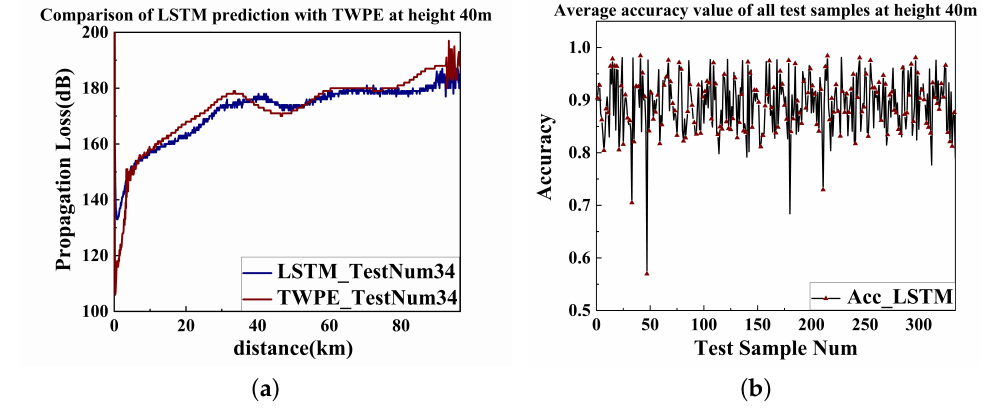
Figure 32. LSTM prediction at a height of 40 m and accuracy distribution. ( a ) PL prediction using LSTM at an antenna height of 40 m. ( b ) LSTM of PL at a height of 40 m accuracy on test